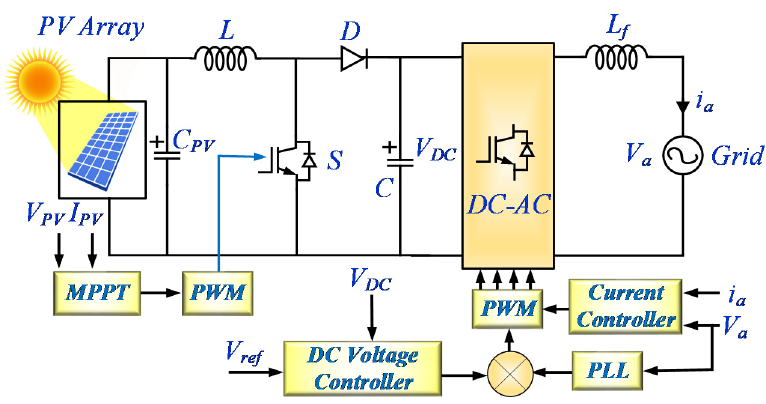
Figure 6. Block diagram of two-stage topology transformerless inverter .